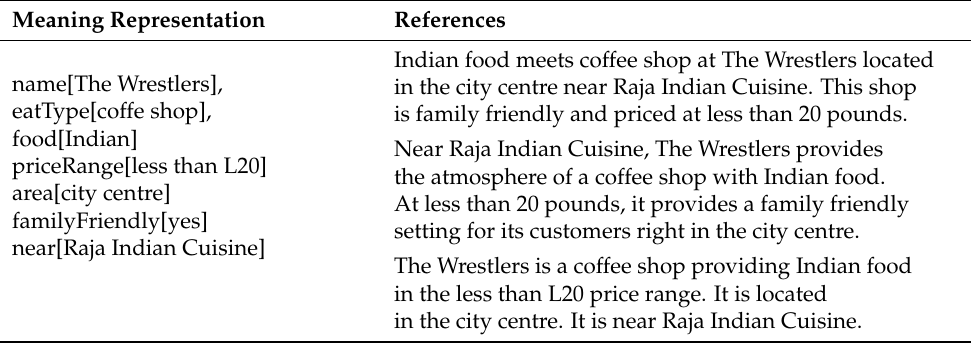
Table 1. An E2E data instance. The meaning representation appears in the dataset once for each reference